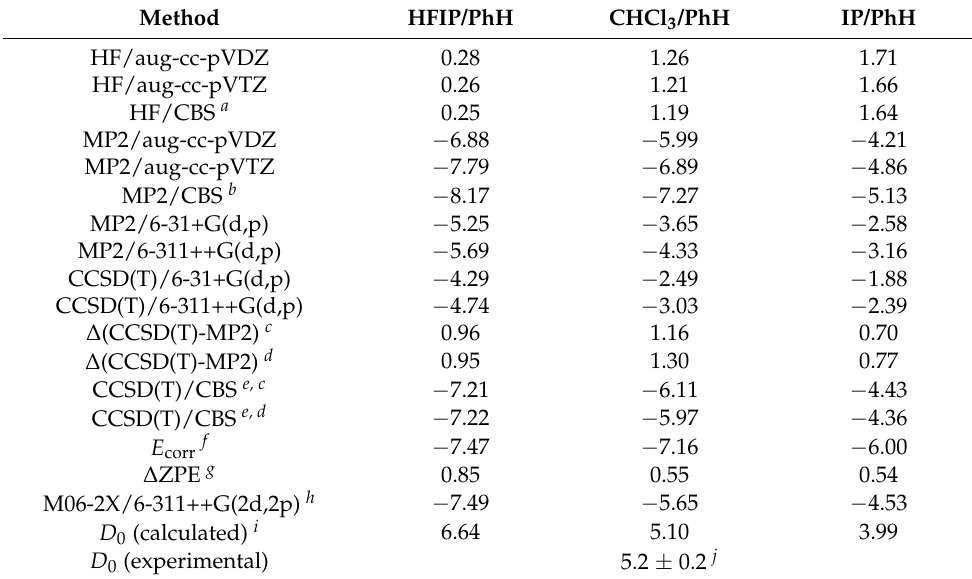
Table 1. Electronic interaction energies (E int ), including counterpoise corrections. Method